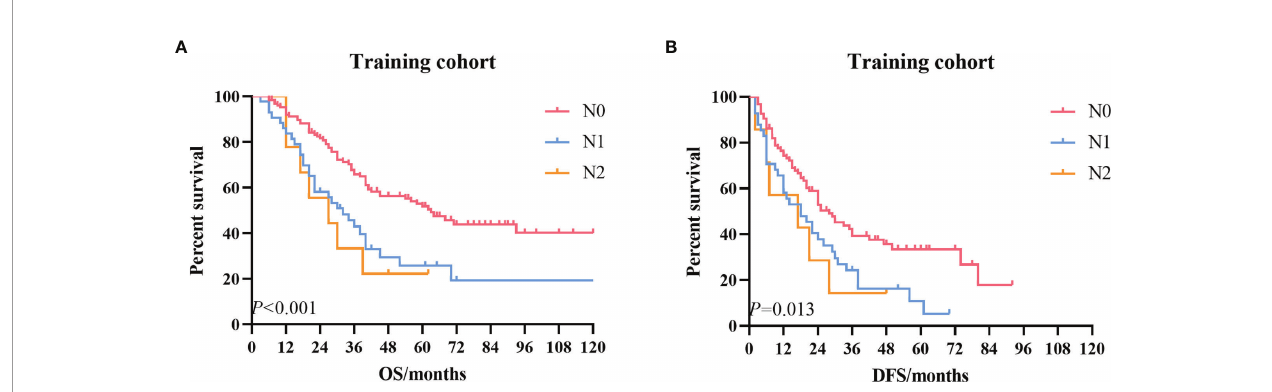
FIGURE 2 | The Kaplan – Meier survival curves according to the N stage. (A) OS curve in the training cohort. (B) DFS curve in the training cohort. OS, overall survival; DFS, disease-free survival.